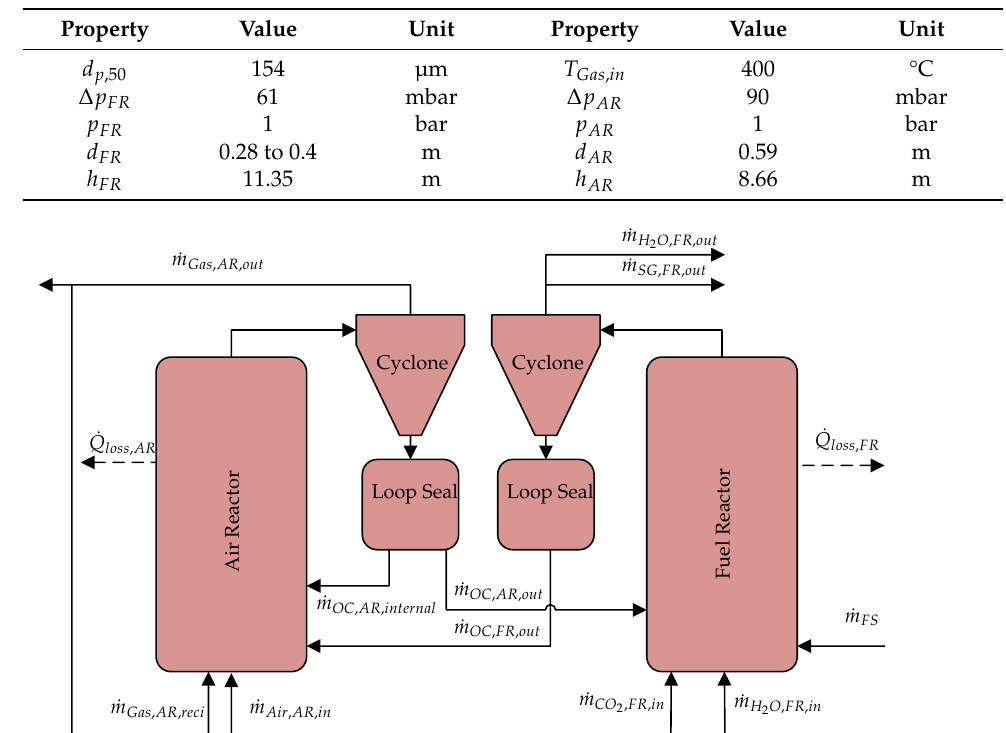
Table 3. Boundary conditions for the simulation of autothermal CLG operations of the 1MW pilot plant.